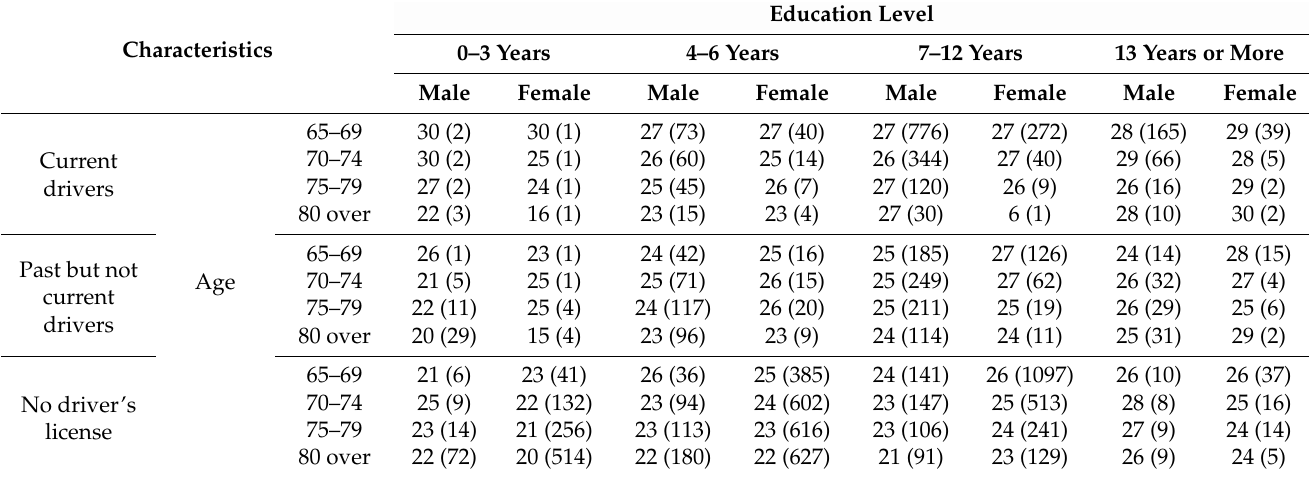
Table 5. Precognitive function